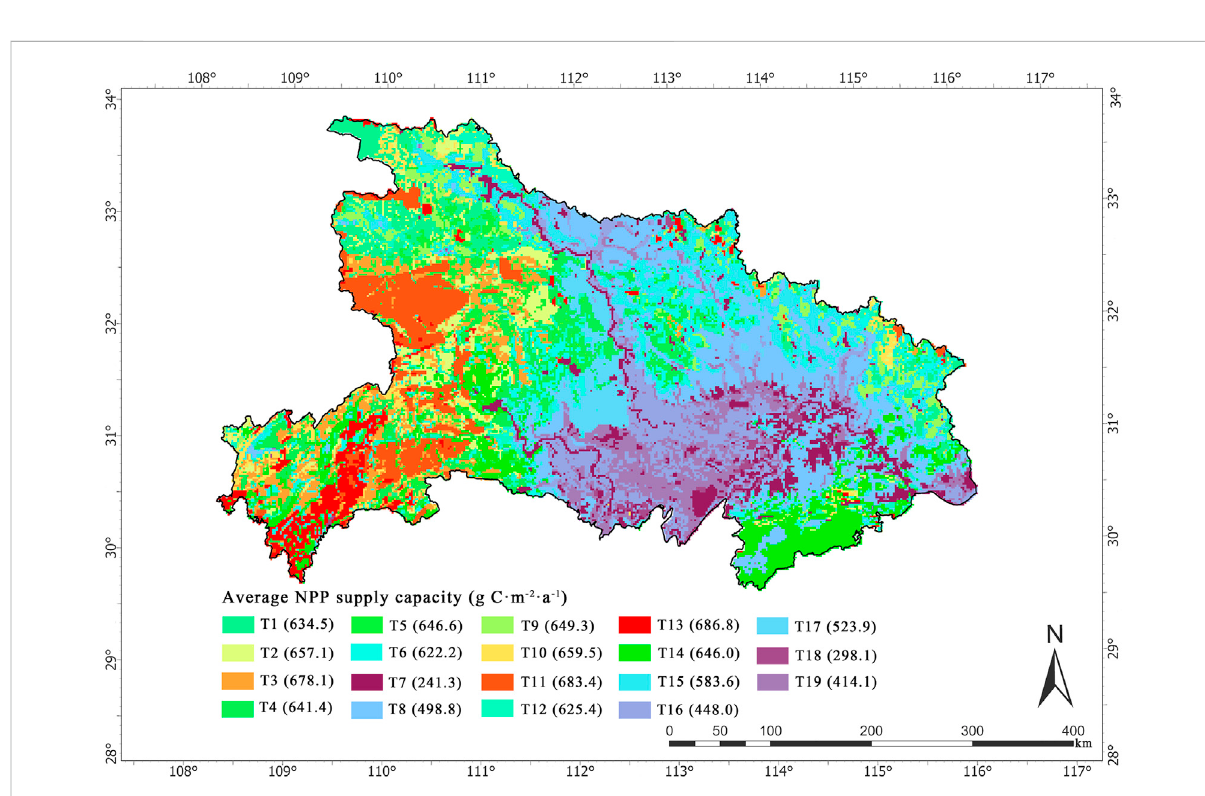
FIGURE 5 Spatial distribution of average NPP supply capacity of different landscape character